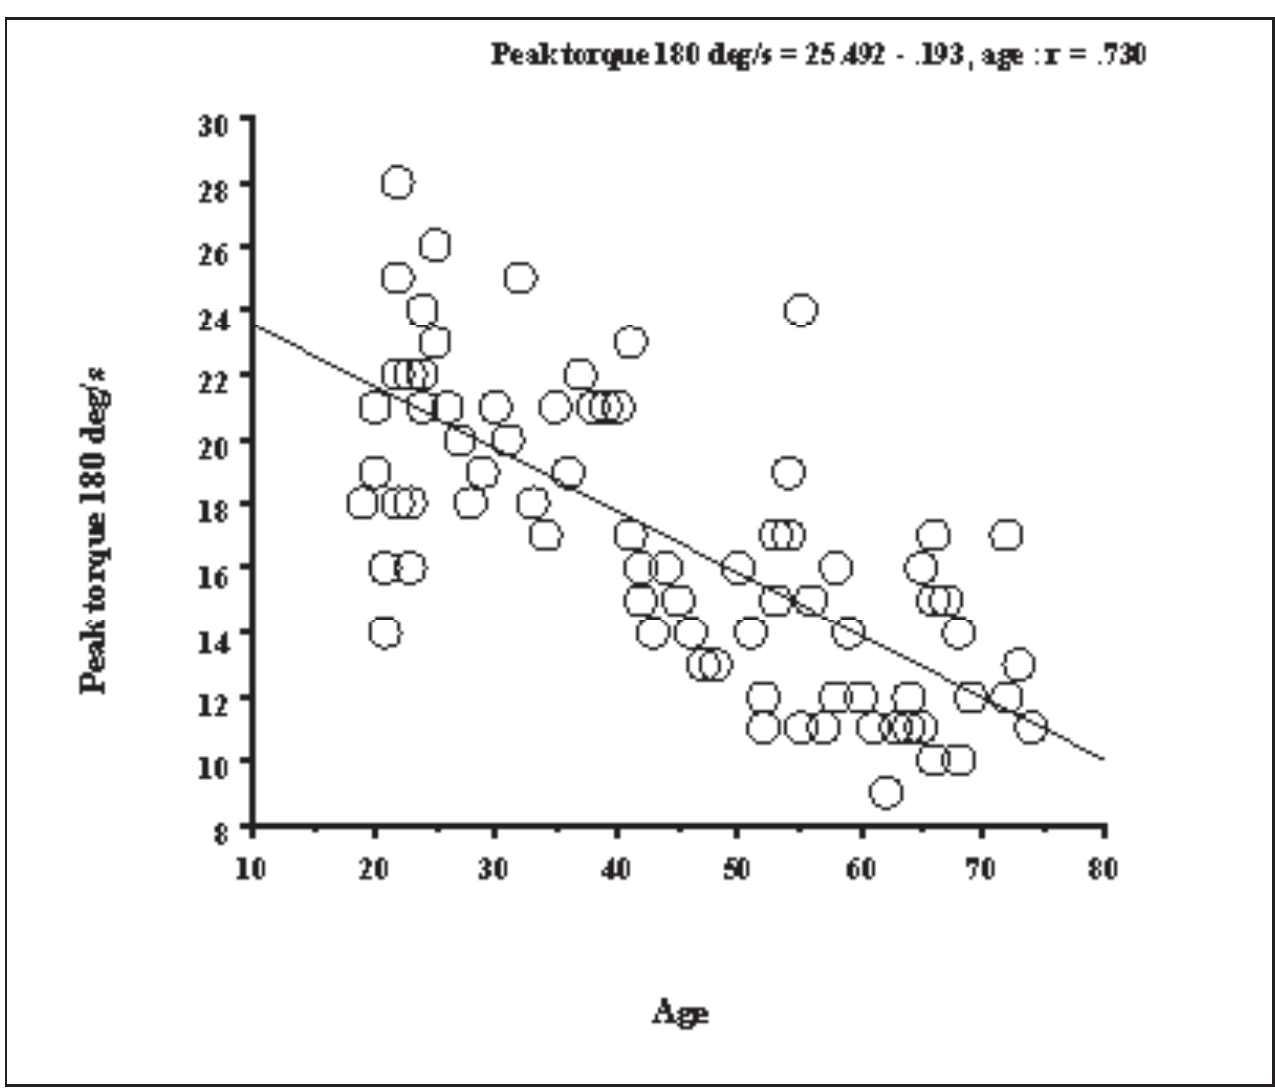
Fig. 2(B): Significant correlation was observed for external rotation peak torque at both velocities with aging. (B: 180 deg/s angular velocity, r = 0.730, p